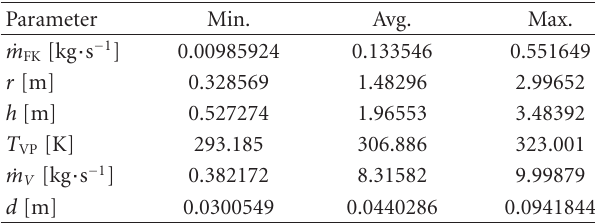
Table 9: Estimated parameters for DERand2Bin.